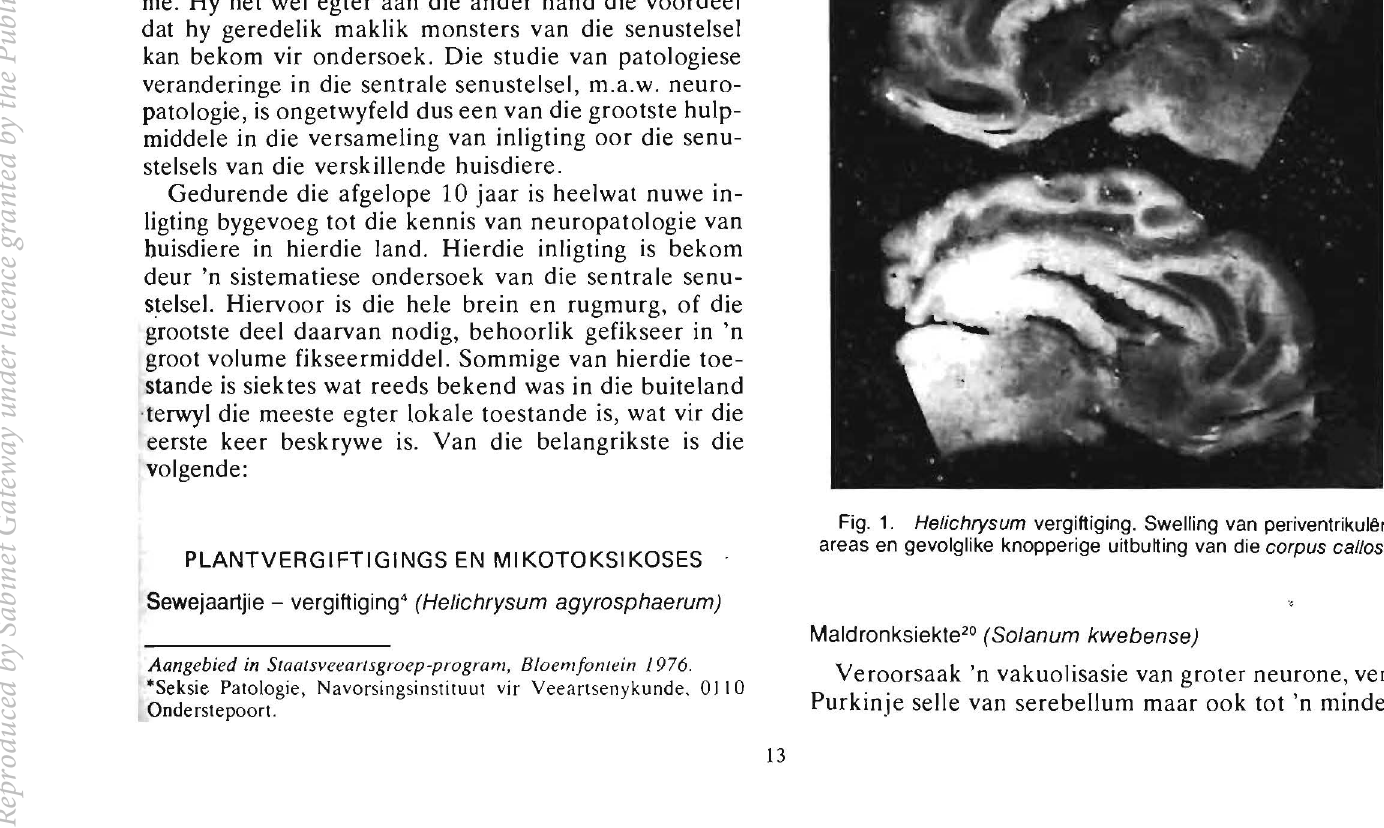
Fig. 1. Helichrysum vergiftiging. Swelling van periventrikul1!re areas en gevolglike knopperige uitbuning van die corpus callosum.